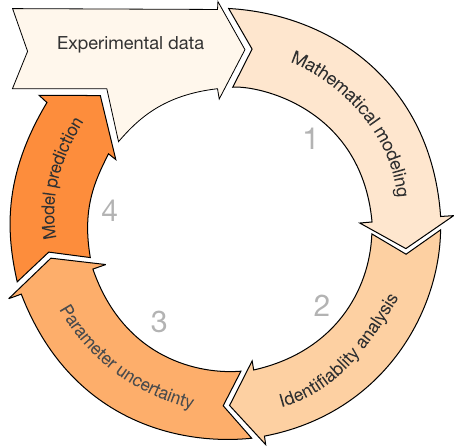
Figure 3. Mathematical modeling approach. From an experimental data set available, a mathematical model is developed/applied ( step 1 );